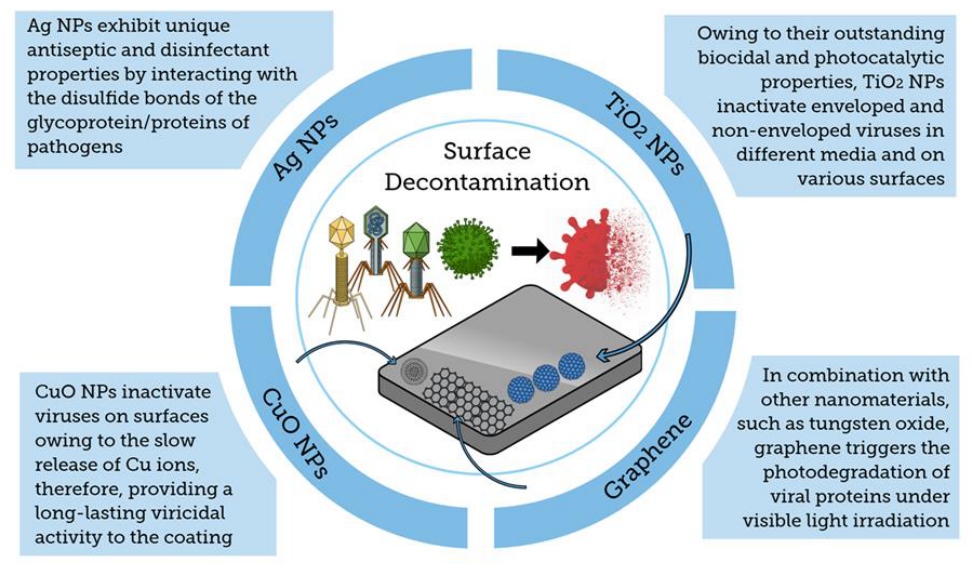
Figure 5. Principal coatings based on nanotechnology to prevent surface contamination by viruses and other